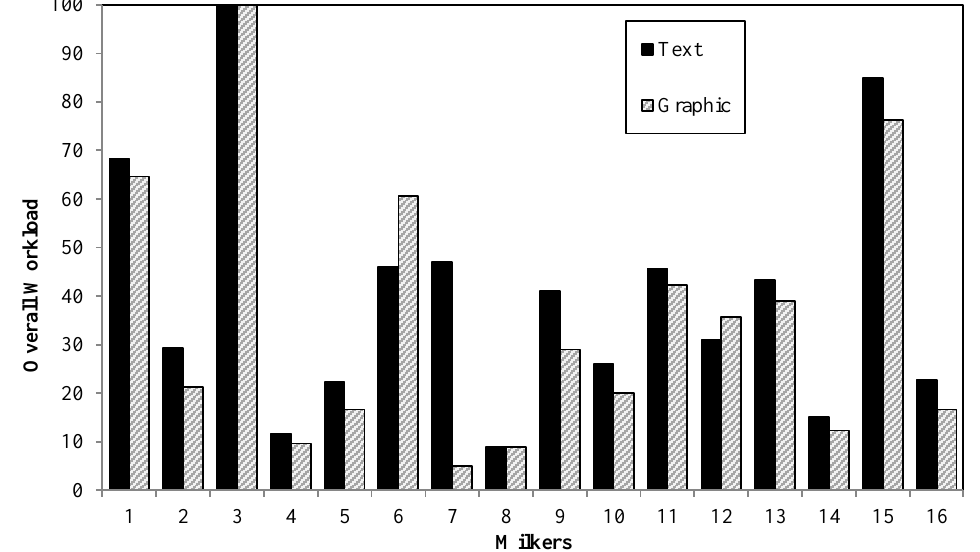
Figure 4. Overall workload by information composition type (text and graphic-based) per milker.